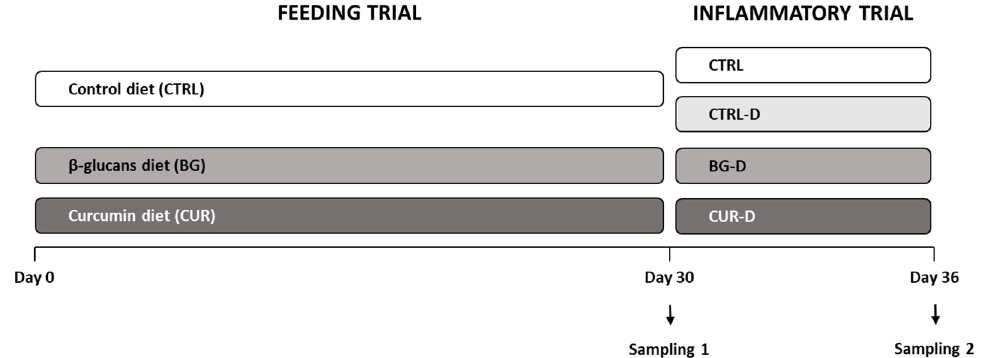
Figure 1. Experimental design of the feeding and gut inflammation trials. CTRL (control diet), BG ( β -glucans diet), CUR (curcumin diet), CTRL-D (control diet + dextran sodium sulphate—DSS), BG-D (β-glucans diet + DSS), CUR-D (curcumin diet + DSS).